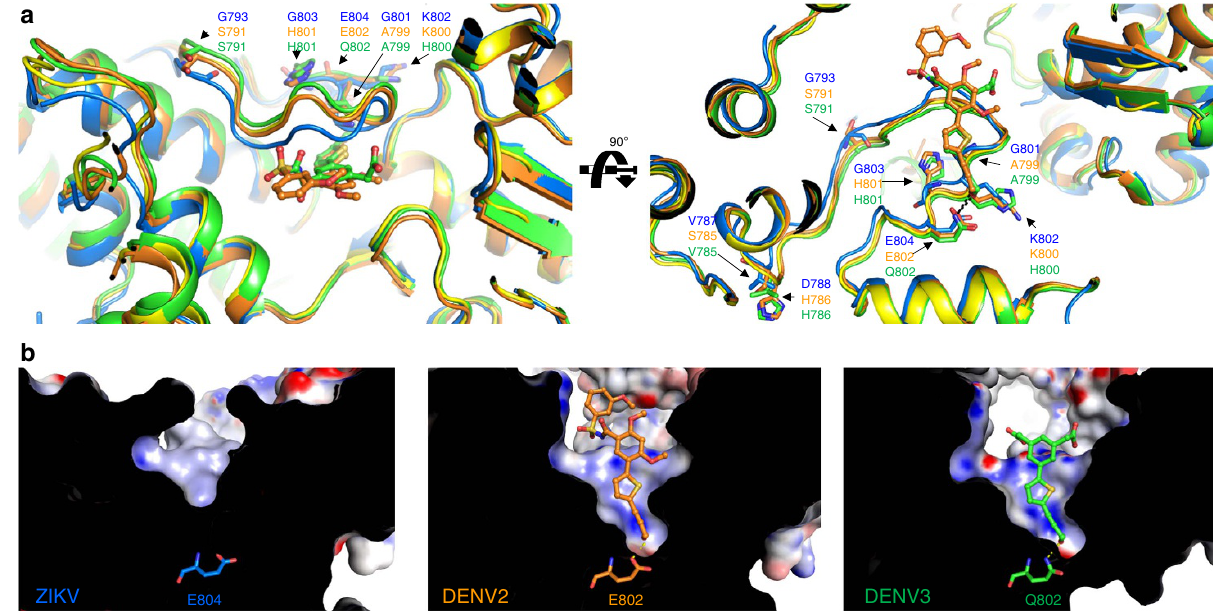
Figure 4 | Structural comparison of Zika and dengue virus NS5 RdRps. ( a ) Orthogonal view of superimposed priming loops in NS5 RdRp domain from ZIKV (5U04, blue), DENV2 in complex with 5-[5-(3-hydroxyprop-1-yn-1-yl)thiophen-2-yl]-2,4-dimethoxy-N-[(3-methoxyphenyl)sulfonyl]benzamide (5K5M, orange) and DENV3 in complex with 2,2 0 -(5-(5-(3-hydroxyprop-1-yn-1-yl)thiophen- 2-yl)-1,3-phenylene)diacetic acid (5HMY, green) and DENV3 apo (2J7U, yellow). ( b ) Close-up views of the priming loop binding sites of ZIKV, DENV2 and DENV3 showing the surface charge distributions (same view as in ( a ) right panel). Positive and negative electrostatic potential are indicated in blue ( þ 50kTe (cid:3) 1 ) and red ( (cid:3) 50kTe (cid:3) 1 ), respectively.